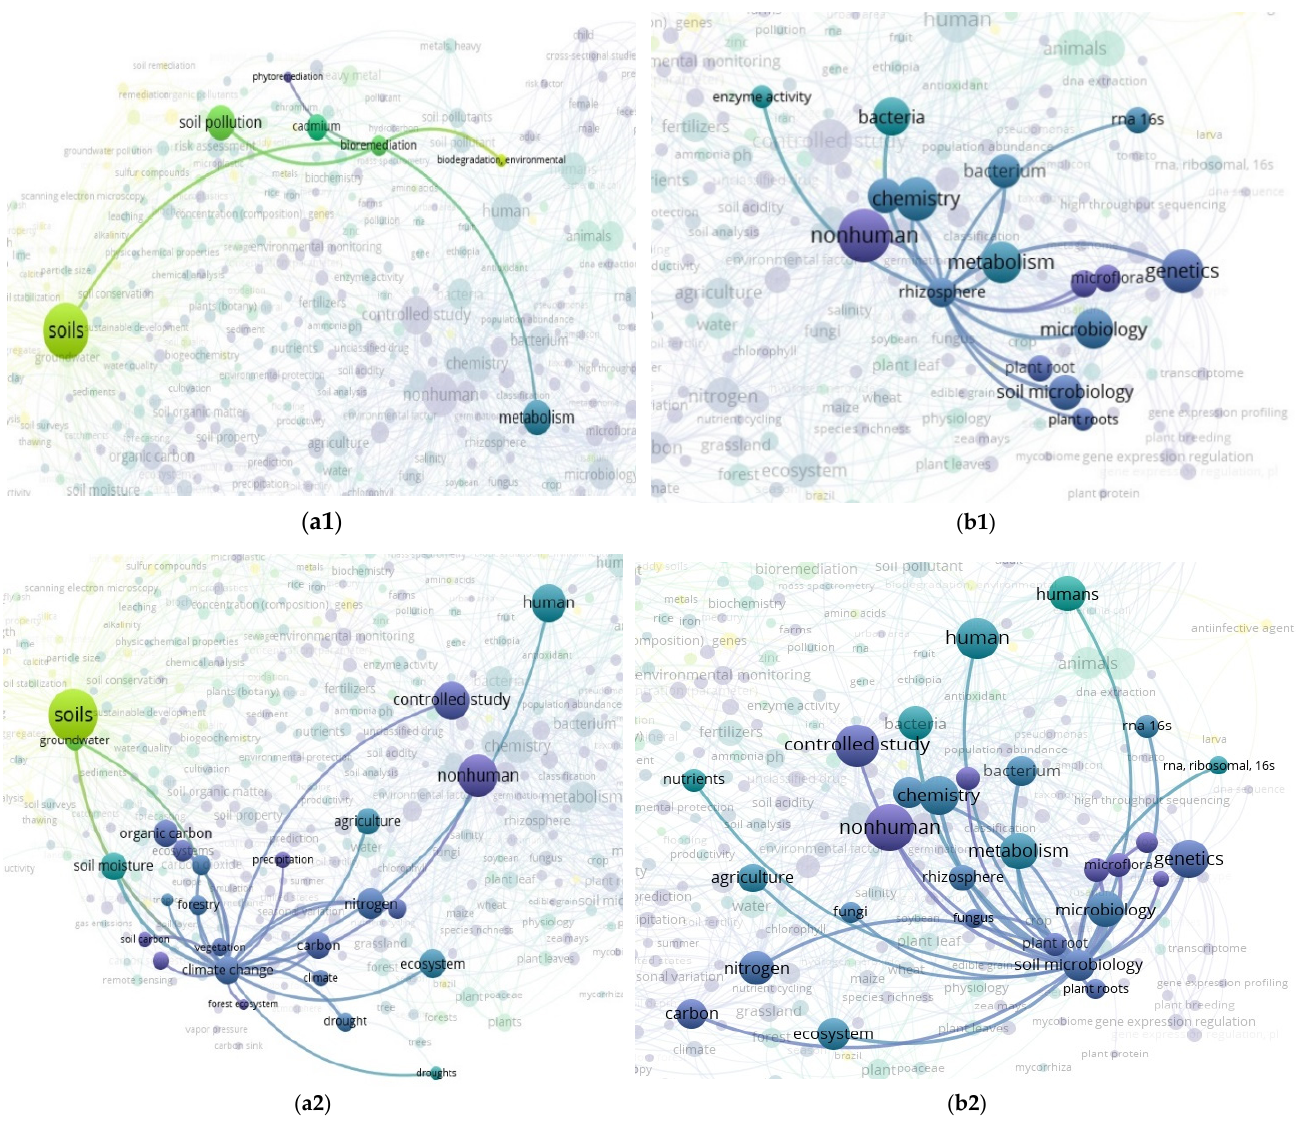
(Figure 3(a1)) is associated with: soils; soil pollution and cadmium (green circles) and metabolism (purple circles); (iv) “Rhizosphere” (Figure 3(b1)) is associated with: chemistry; metabolism; bacteria; microbiology and soil microbiology (green circles) and microflora (purple circles); (v) “Climate change” (Figure 3(a2)) is associated with: soils (green circle) and ecosystem; organic carbon and human (purple circles); (vi) “Soil microbiology” (Figure 3(b2)) is associated with: chemistry; metabolism; agriculture human(s); ecosystem; nutrients; bacteria and fungi (green circles) and carbon and nitrogen (purple circles).